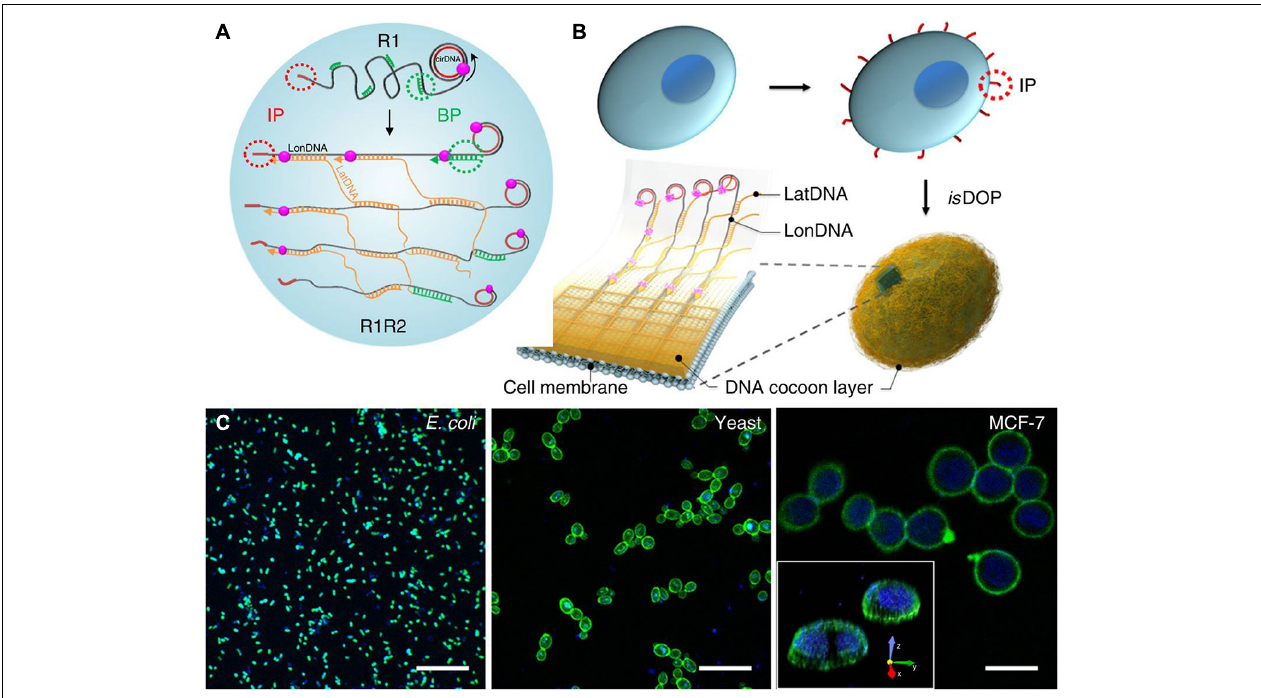
FIGURE 8 | Schematic diagram of design and fabrication of flexible DNA-based hydrogel cocoons to encapsulate live cells: (A,B) the preparation of DNA-based hydrogel cocoons; (C) the scanning confocal microscope images of typical cell types encapsulated in the cocoons. Reprinted under the terms and conditions of